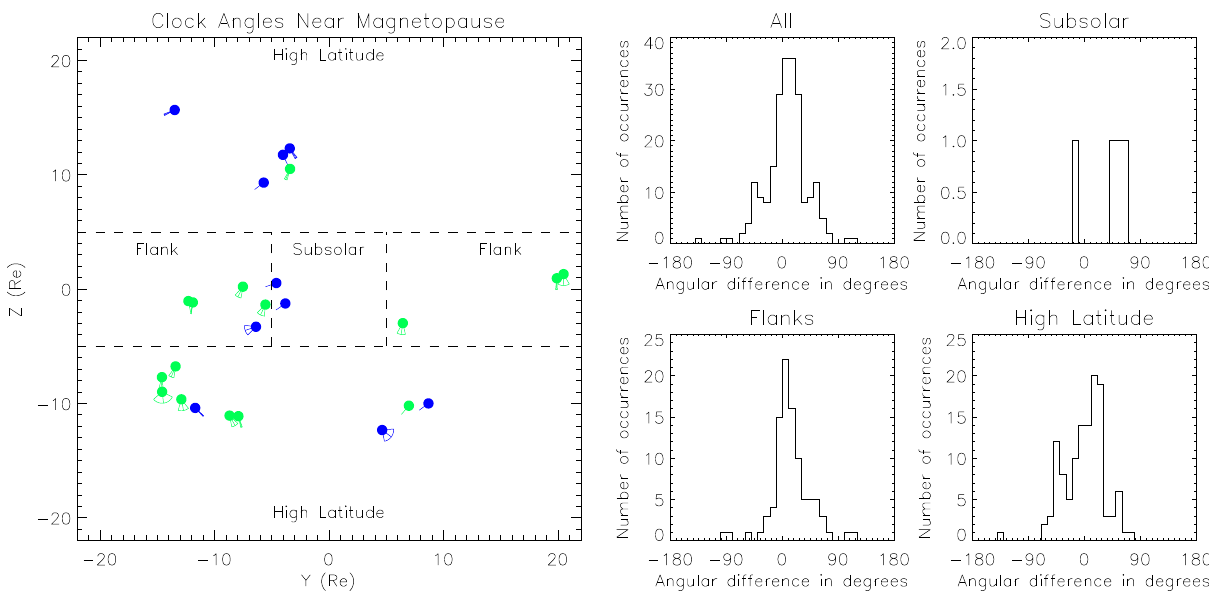
Fig. 5. Clock angles measured near magnetopause, and angular differences from perfect draping, for Southward IMF. Format as Figure 2.